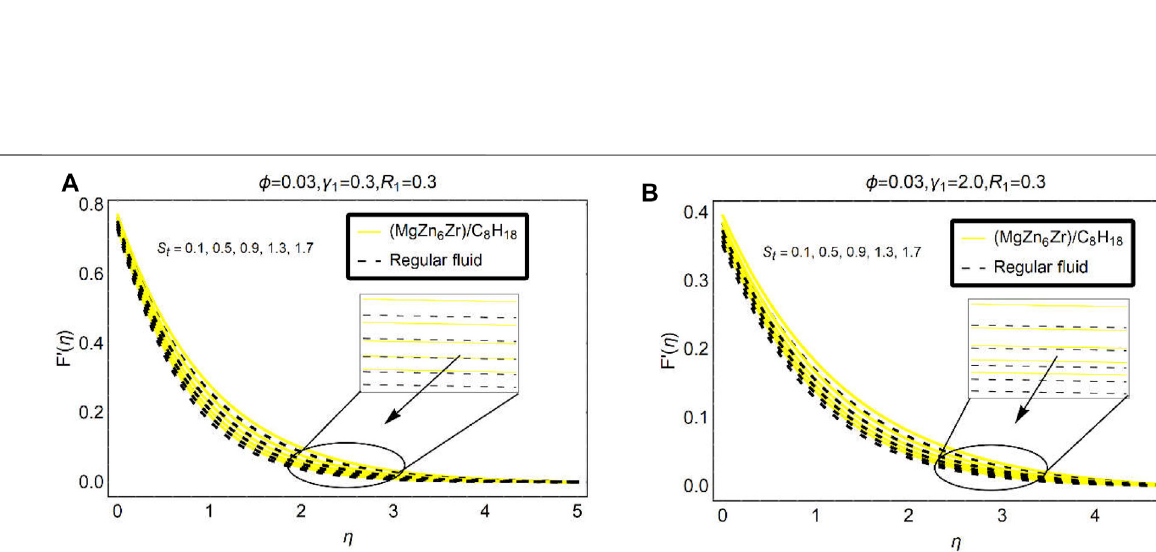
Frontiers in Energy Research |